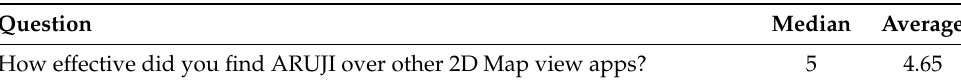
Table 4. Effectiveness of ARView in compared to Map View using a Likert scale: 1–5 (1: Not at all, 5: Very